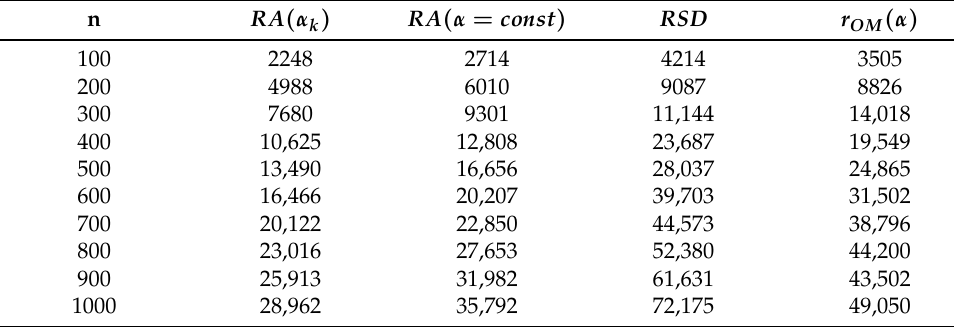
Table 4. Function f 4 ( x ) minimization